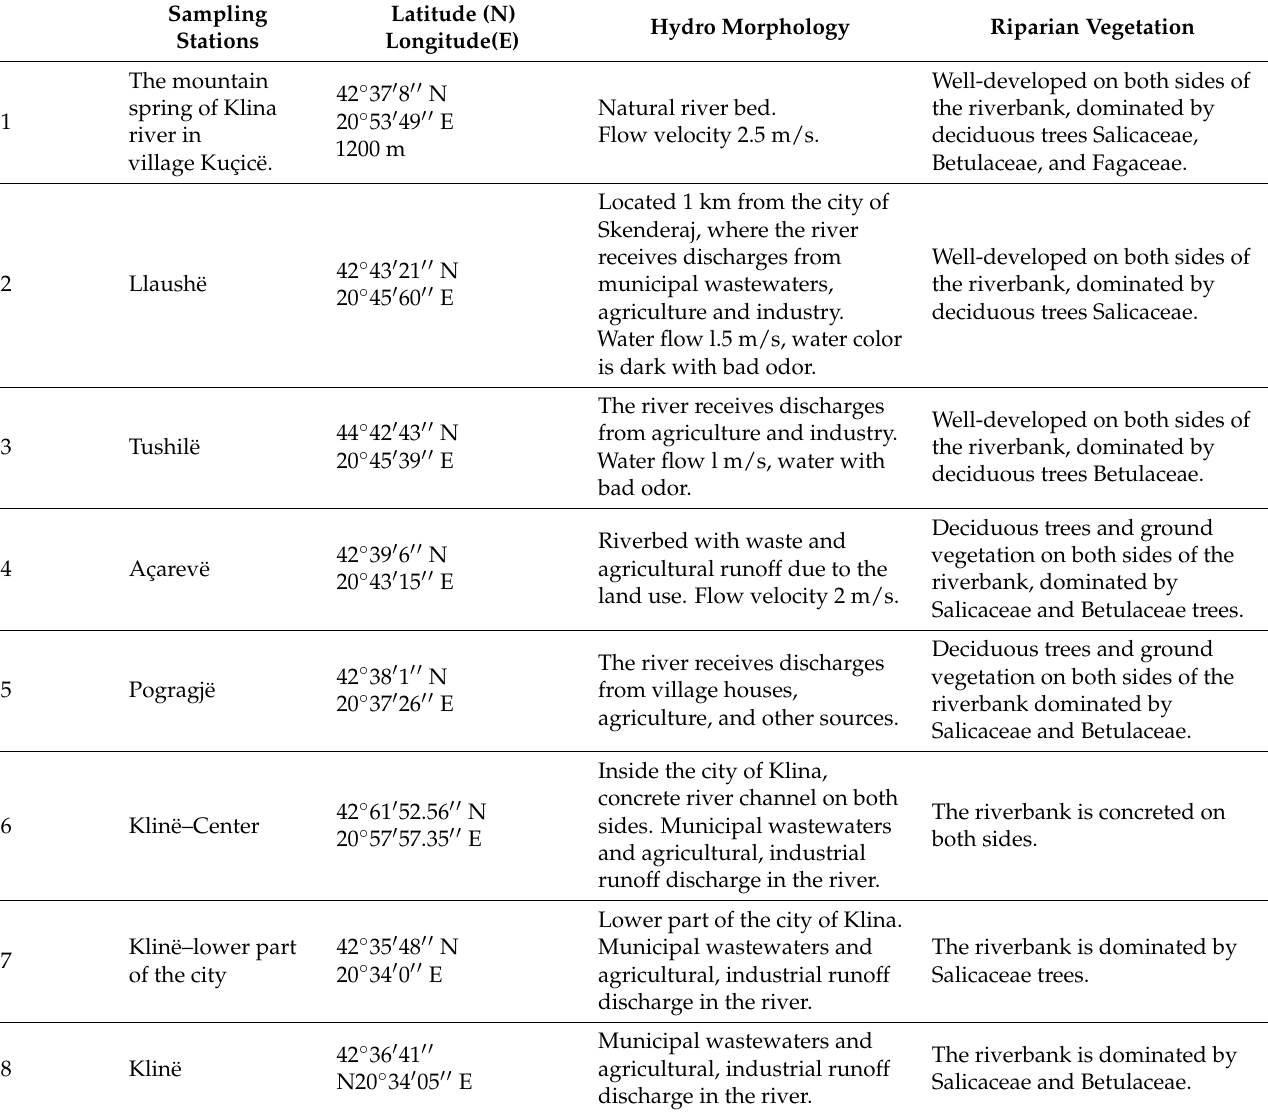
Table 1. The sampling sites with geographic coordinates, hydro morphology and Riparian